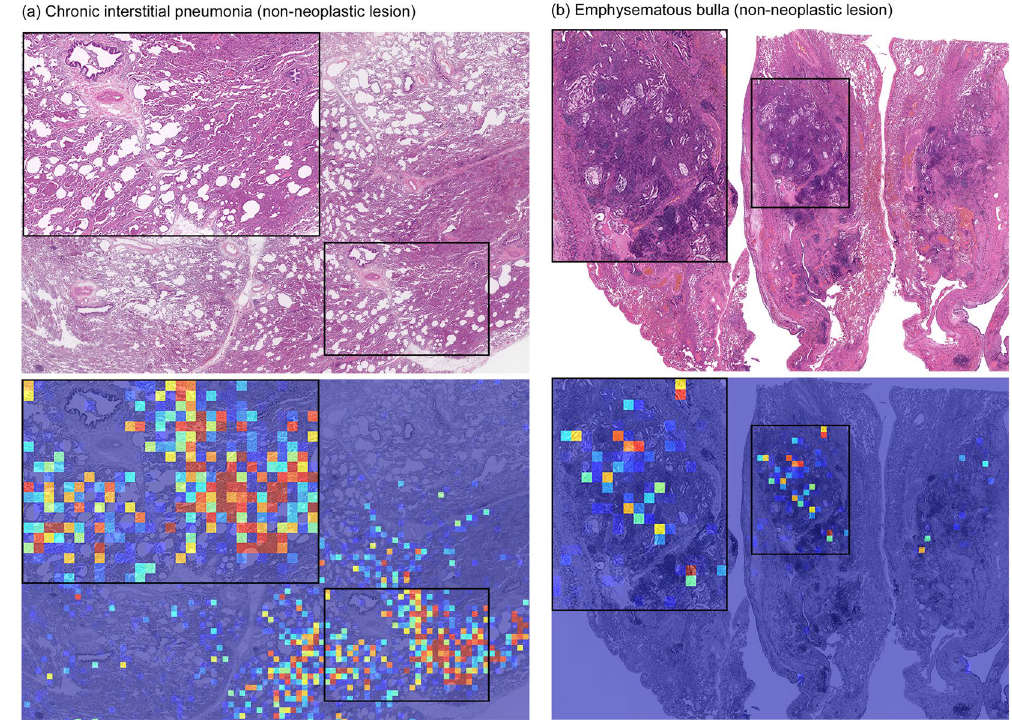
Figure 5. Examples of two carcinoma false positive prediction outputs using the weakly-supervised method. ( a ) Is a case of chronic interstitial pneumonia: there are prominent appearances of macrophages in the alveolar space and fibrosis of the alveolar septum as a background of mild to moderate chronic active inflammation. Infiltrating inflammatory cells include lymphocytes, monocytes, and neutrophils. ( b ) Is a case of emphysematous bulla: there is a cystic emphysematous space in the lung beneath the pleura. Chronic inflammation, congestion and hemorrhage are seen. The inflammatory tissues in ( a , b ) is the main cause of false positive prediction due to the resemblance to cancer stroma.